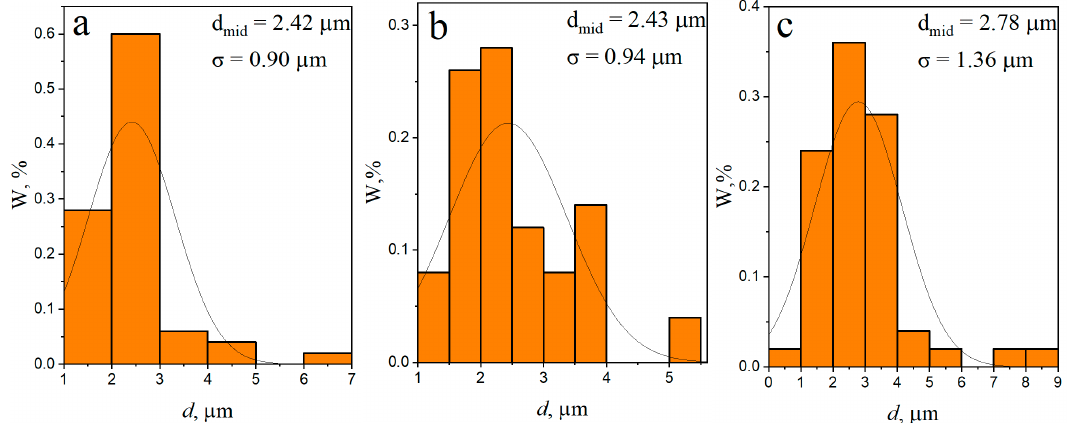
Figure 10. Average grain size and grain size distribution FSP-ed RPPs/AA5056 composite in the processing zone after 8 passes: ( a ) stir zone; ( b ) thermomechanically affected zone; ( c ) base metal.